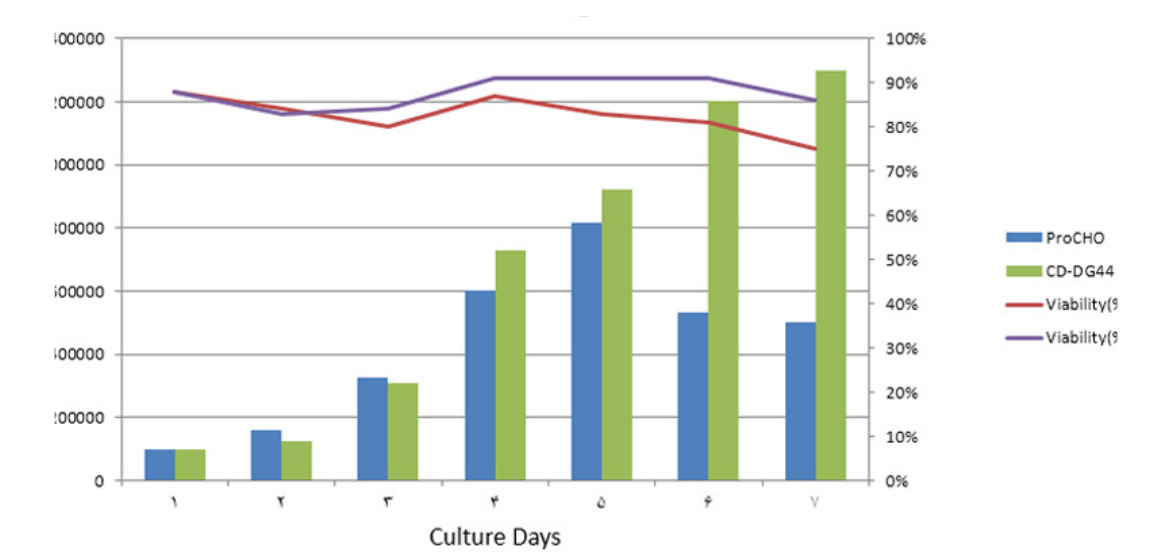
FIGURE 2 - The viability and density of CHO-DG44 cells in CD-DG44 and ProCHO5